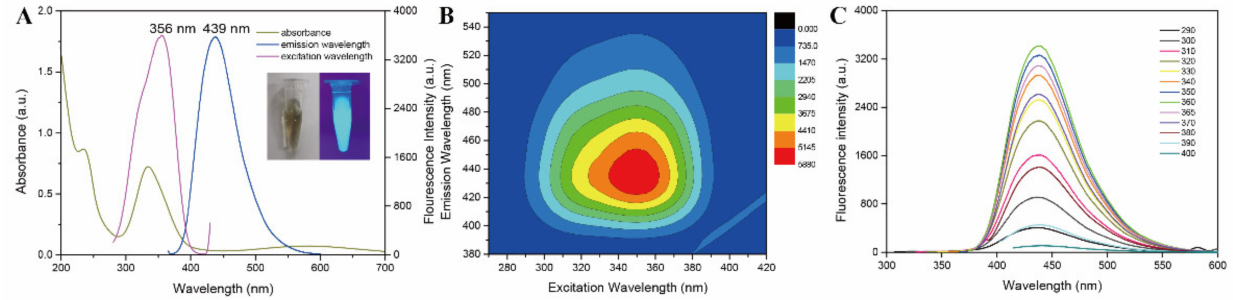
Figure 2. Optical characterization results of bCDs. ( A ) UV/Vis absorption and fluorescence spectra at optimum excitation wavelengths (Inset: photo of bCDs solution in daylight and under 365 nm lamp); ( B ) Results of 3D-Scanning fluorescence emission spectra of bCDs at excitation wavelengths ranging from 280 to 420 nm; ( C ) Fluorescence emission spectra collected from the bCDs.